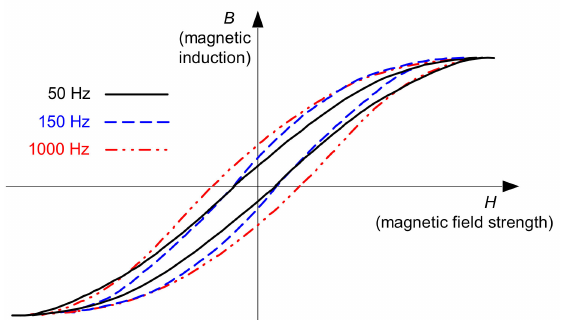
Figure 16. Measured hysteresis loops of the current sensor of the 30 mA A-type RCD, for frequencies of 50, 150, and 1000 Hz.